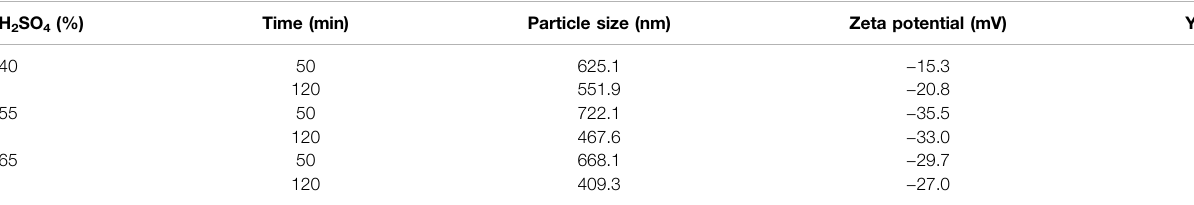
TABLE 3 | Particle size, zeta potential, and yield of CNCs at 55 ° C. H 2 SO 4 (%)